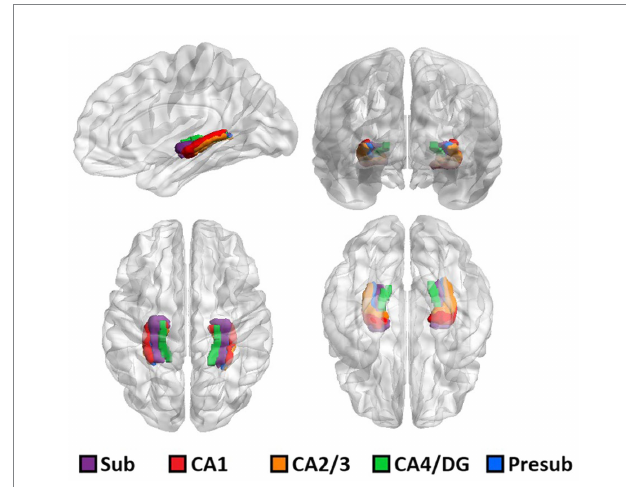
FIGURE 1 3D rendering of one representative subject’s brain with an overlay of the automated hippocampal subfields segmentation.